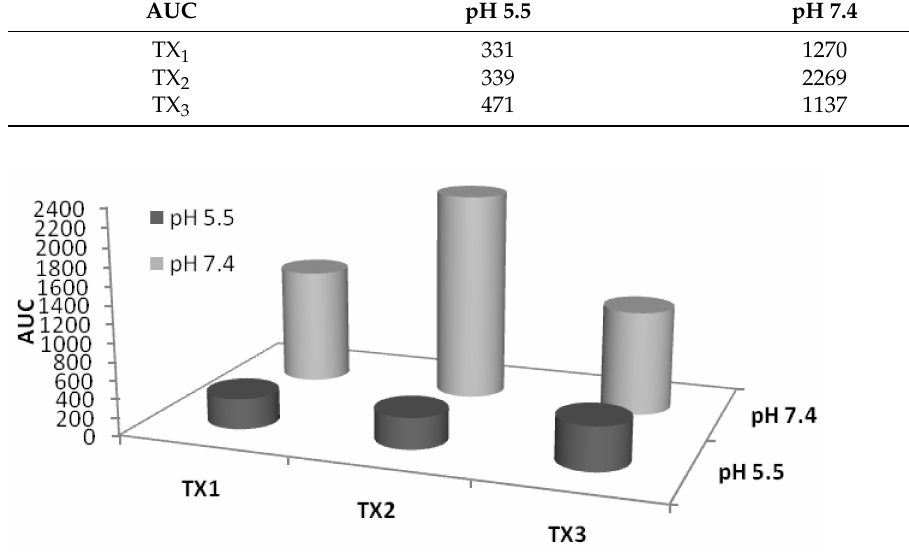
Figure 6. The influence of the polymeric films, depending on pH, on the dissolution